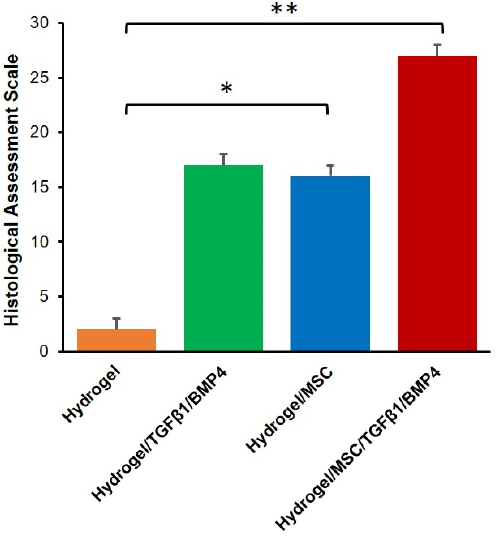
Figure 7. Histological assessment scale for repaired osteochondral defects. Data are presented as mean ± SD (n = 4). * p < 0.05, ** p < 0.01.